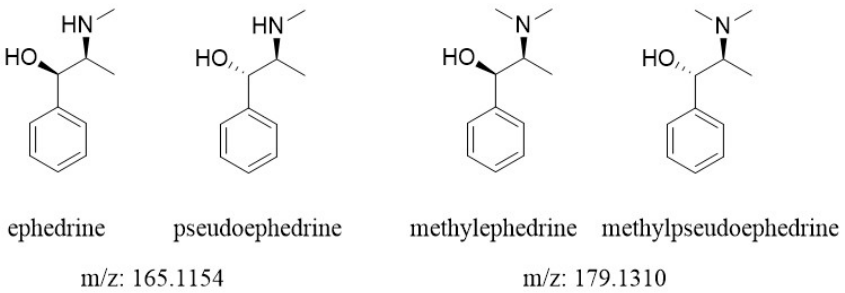
Figure 1. Major alkaloids of ephedra plants. Ephedrine and its diastereomer pseudoephedrine have the same molecular weight, so it is not differentiated by a mass spectrometer, and the same is true in the case of methylephedrine and methylpseudoephedrine. Ephedrine/pseudoephedrine: C 10 H 15 NO, methylephedrine/methylpseudoephedrine: C 11 H 17 NO.